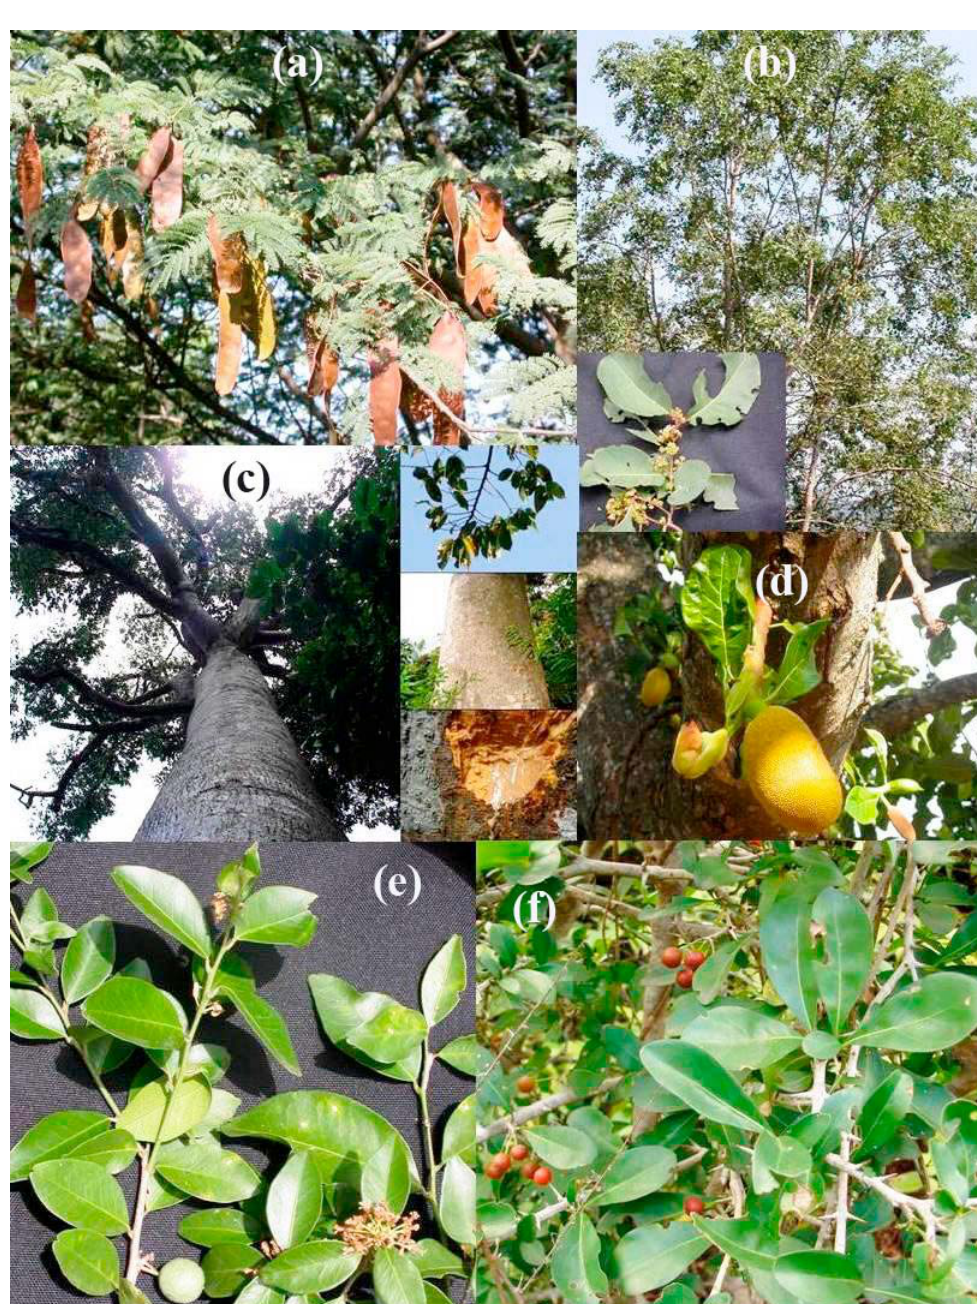
Figure 5. a) Albizia amara (Mimosaceae); b) Anogeissus latifolia (Combretaceae); c) Antiaris toxicaria (Moraceae); d) Artocarpus heterophyllus (Moraceae); e) Atalantia monophylla (Rutaceae); f) Benkara malabarica (Rubiaceae). Photo by L. Arul